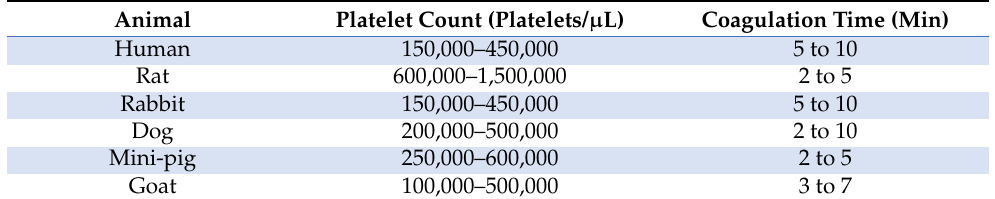
Table 5. Comparison of platelet count and coagulation time between humans and various animal models: an overview. Animal Platelet Count (Platelets/ µ L) Coagulation Time (Min) Human 150,000–450,000 5 to 10 Rat 600,000–1,500,000 2 to 5 Rabbit 150,000–450,000 Dog 200,000–500,000 2 to 10 Mini-pig 250,000–600,000 2 to 5 Goat 100,000–500,000 3 to